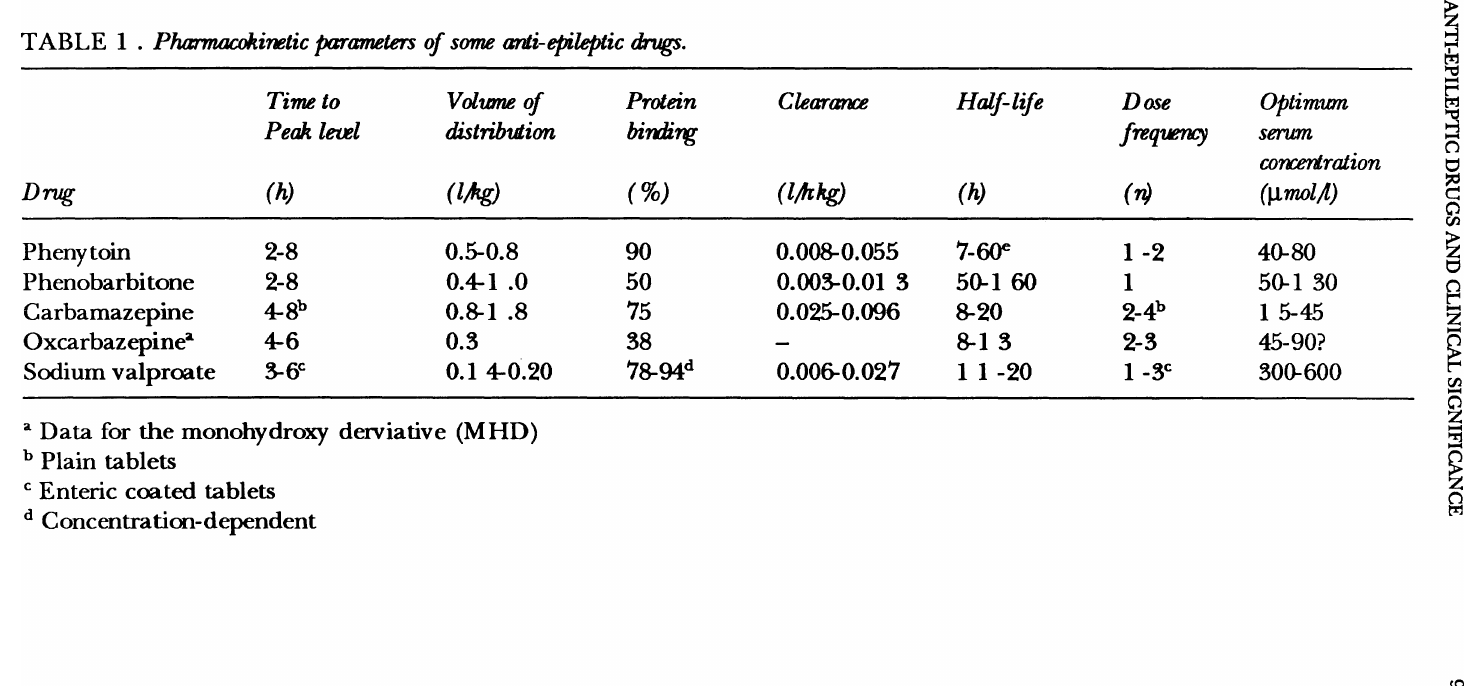
TABLE 1 . Pha:rmocoki'Tll!tic parameters of some anti-epileptic drogs. Ti1TlJ! to Volume of Protein Clearana Half-life Dose optirrnon t'"' M Peak leal distribution bimi1f!: frequency serum ~ Drug (h) (lk) (%) (lthkg) (h) (n) (~mol;f) ~